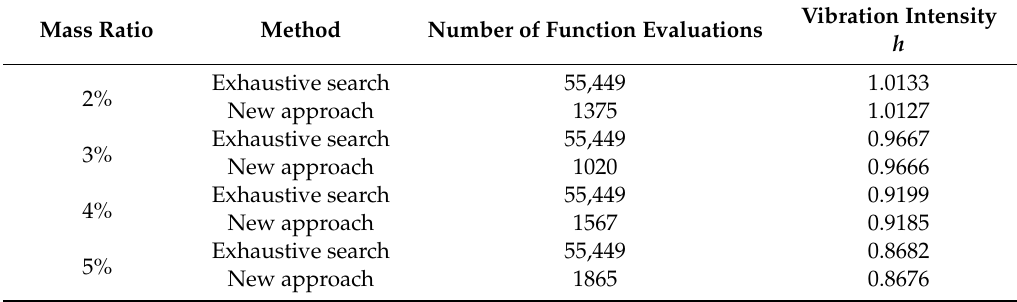
Table 2. Comparison between the exhaustive method and the proposed approach for various TMD masses.